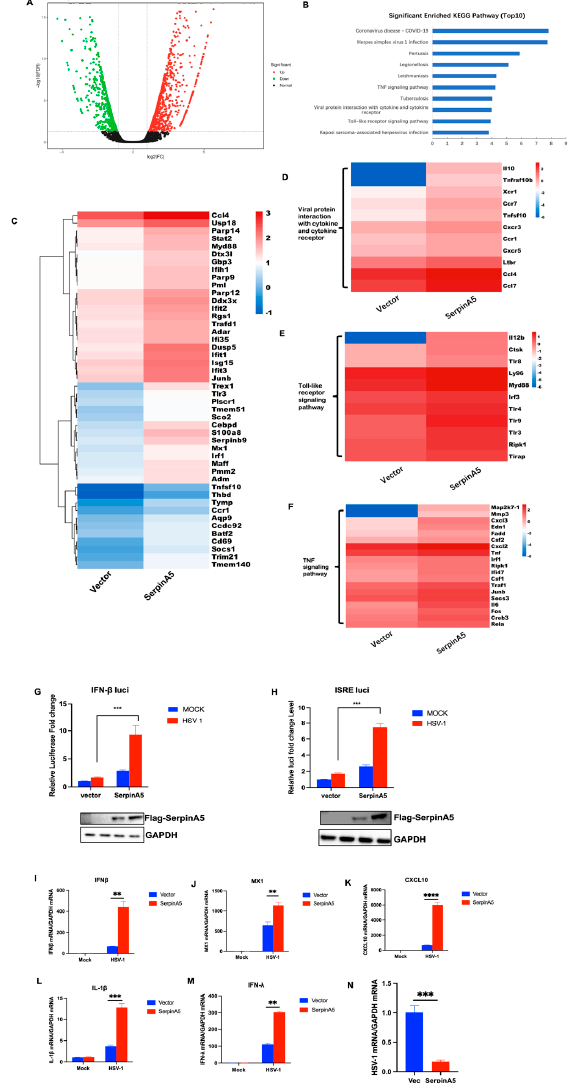
Figure 2. SerpinA5 played an antiviral function through modulating IFN-related signaling pathways. A549 cells were transfected with 2 μ g SerpinA5-expressing plasmid or mock vector for 24 h and then infected with HSV − 1. Transcriptome analysis was then carried out by RNA sequencing .